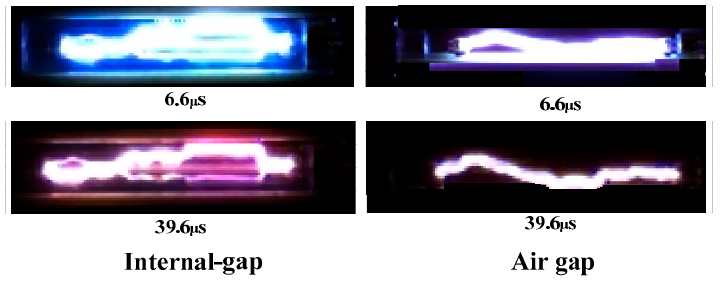
Figure 8. Photos obtained with the high-speed camera.